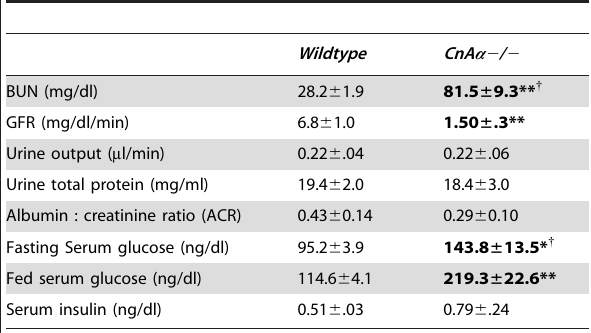
Table 2. Kidney function in CnA a 2 / 2 and WT littermates.